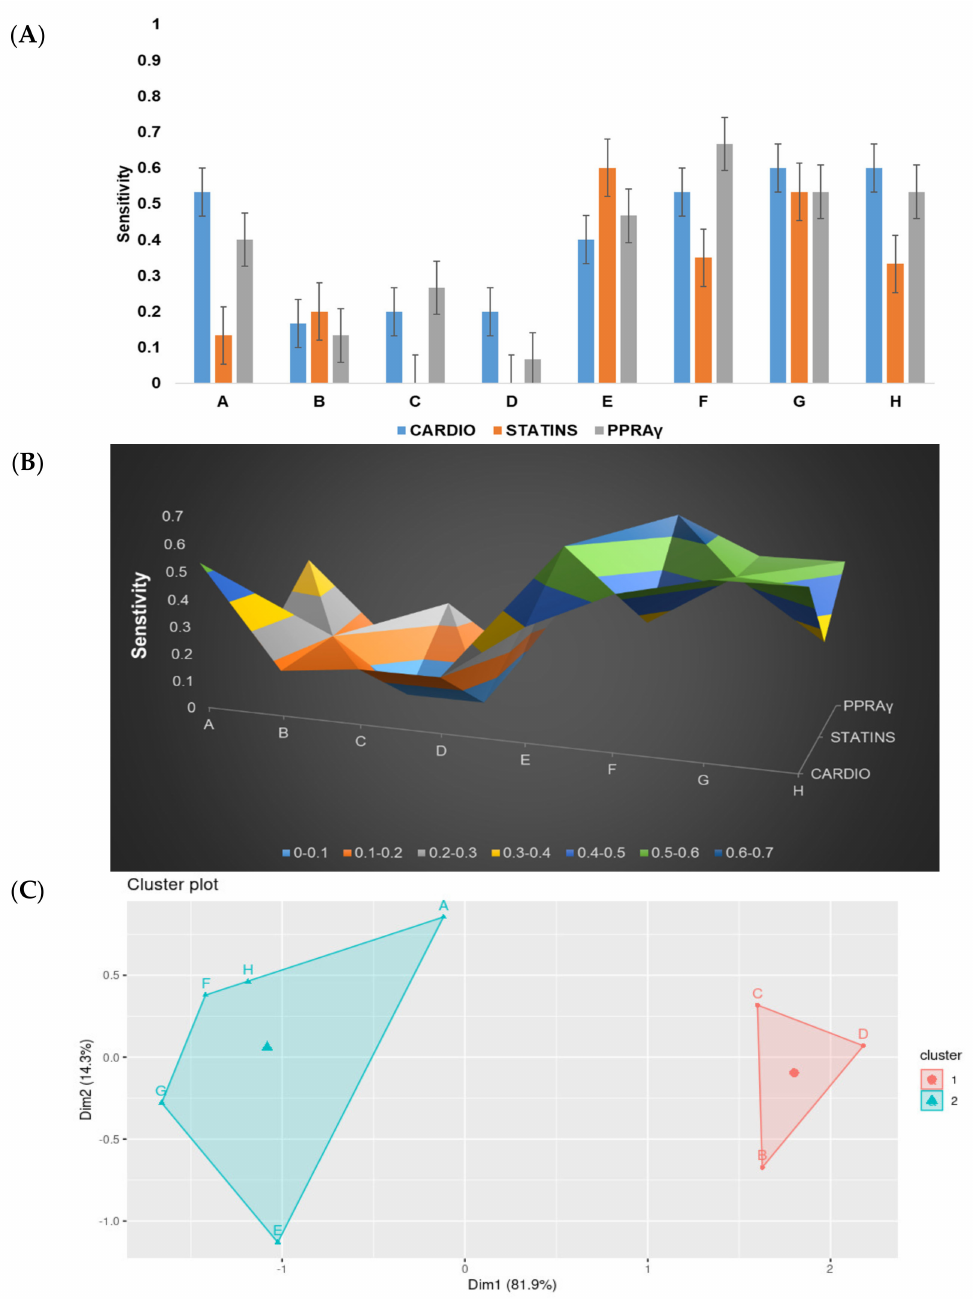
Figure 5. Sensitivity analysis of the investigated models based on their ability to identify known drugs. To validate the performance of our models, we compared their performance using three types of questions. ( A , B ) We found that models G and H achieve the highest sensitivity on generic questions. ( A , B ) Model F could be more suitable for the pathway question–answer category. ( C ) Our K-means clustering analysis indicates that the models separate based on their sensitivity into a cluster containing the B, C, and D models and another cluster containing the models’; A, E, F, H, and